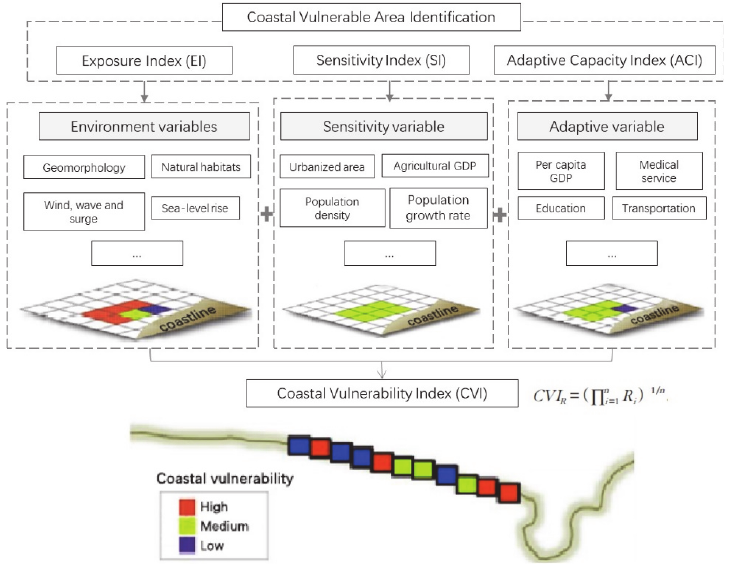
Figure 4. Framework of coastal vulnerable area identification.